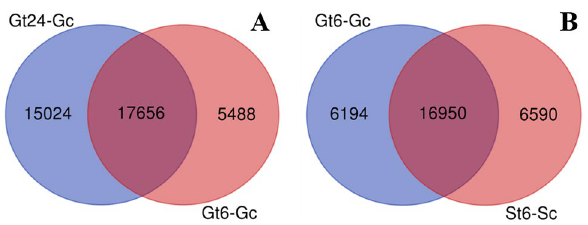
Figure 3. Common and specific coding salt responsive genes from two P. vera genotypes. ( A ) Venn diagram shows the number of common and specific differentially expressed genes between Gt24-Gc and Gt6-Gc. ( B ) Venn diagram shows the number of common and specific differentially expressed genes between Gt6-Gc and